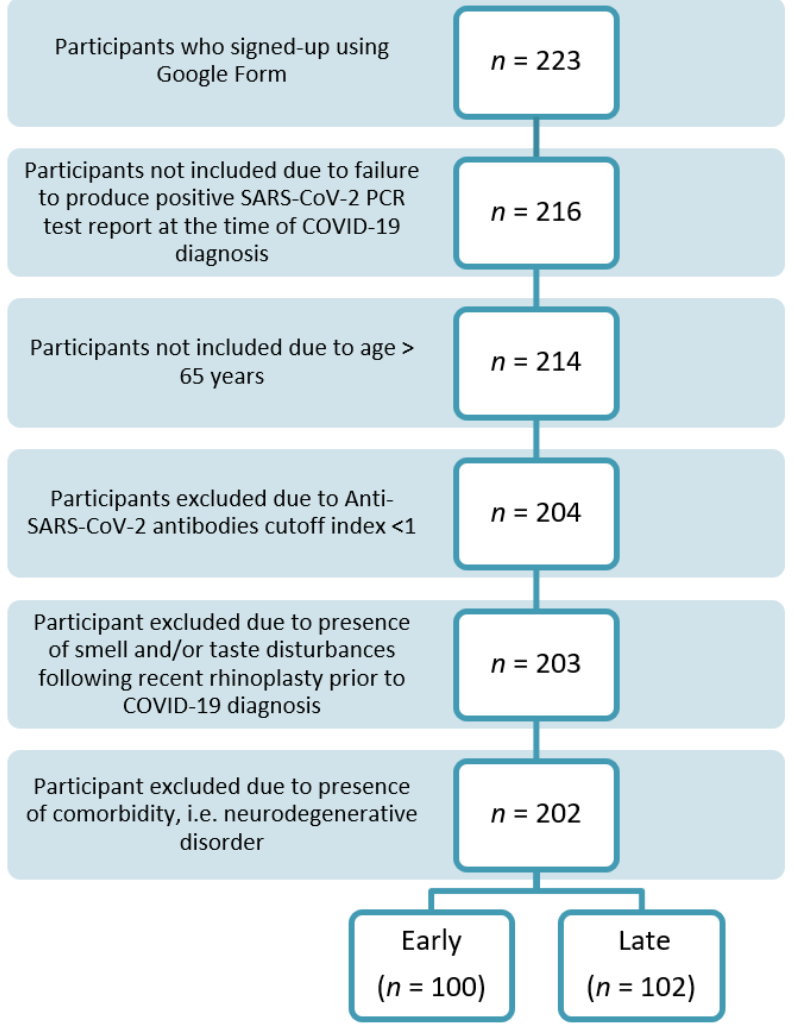
Figure 1. Flow chart graphically represents the study participants.